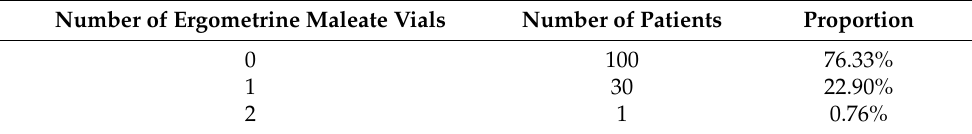
Table 13. Distribution of patients regarding the number of ergometrine maleate vials received during the third stage of labor.